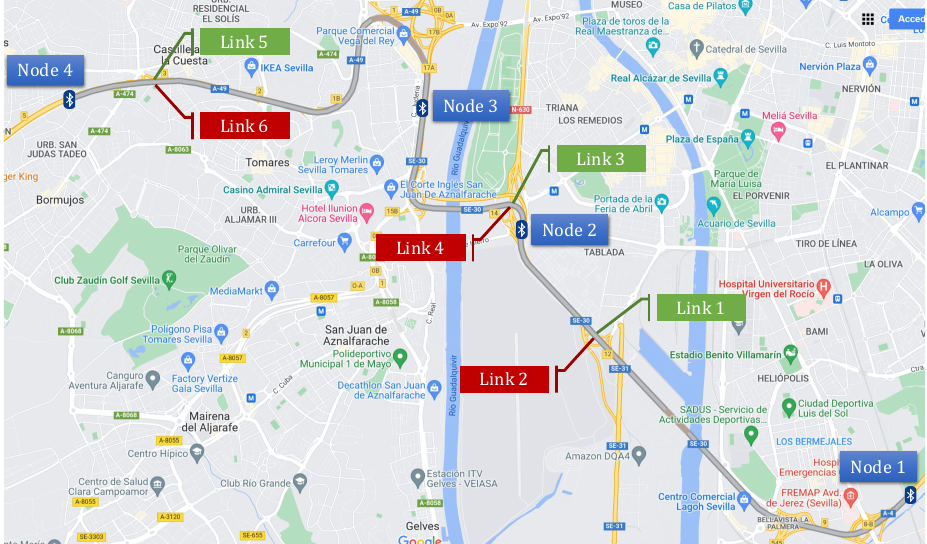
Figure 1. Nodes and links in the BTMS deployed in Seville